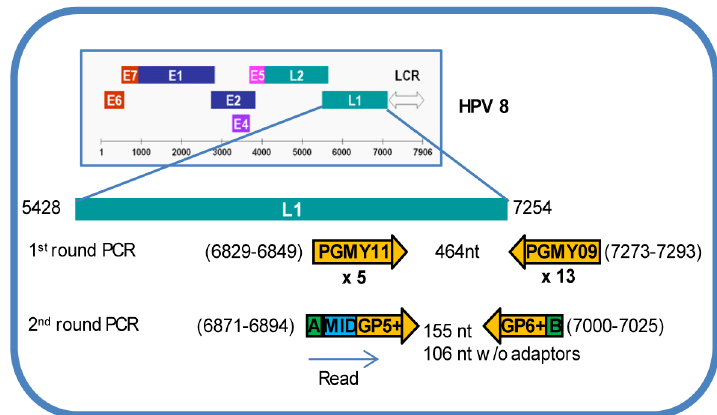
Figure 1. Primer sets used to generate human papillomaviruses (HPV) L1 amplicon libraries. A cocktail of PGMY11/09 PGMY consensus primers was used in 1st-round amplification to produce a product of 464 nucleotides (nt). GP5+ and GP6+ consensus primers conjugated at 5’ end with adaptors A or B respectively, were used in 2nd-round amplification to produce a product of 155 nt (106 nt w/o adaptors, multiplex identifier (MID) and primers). Primer positions are based on HPV8